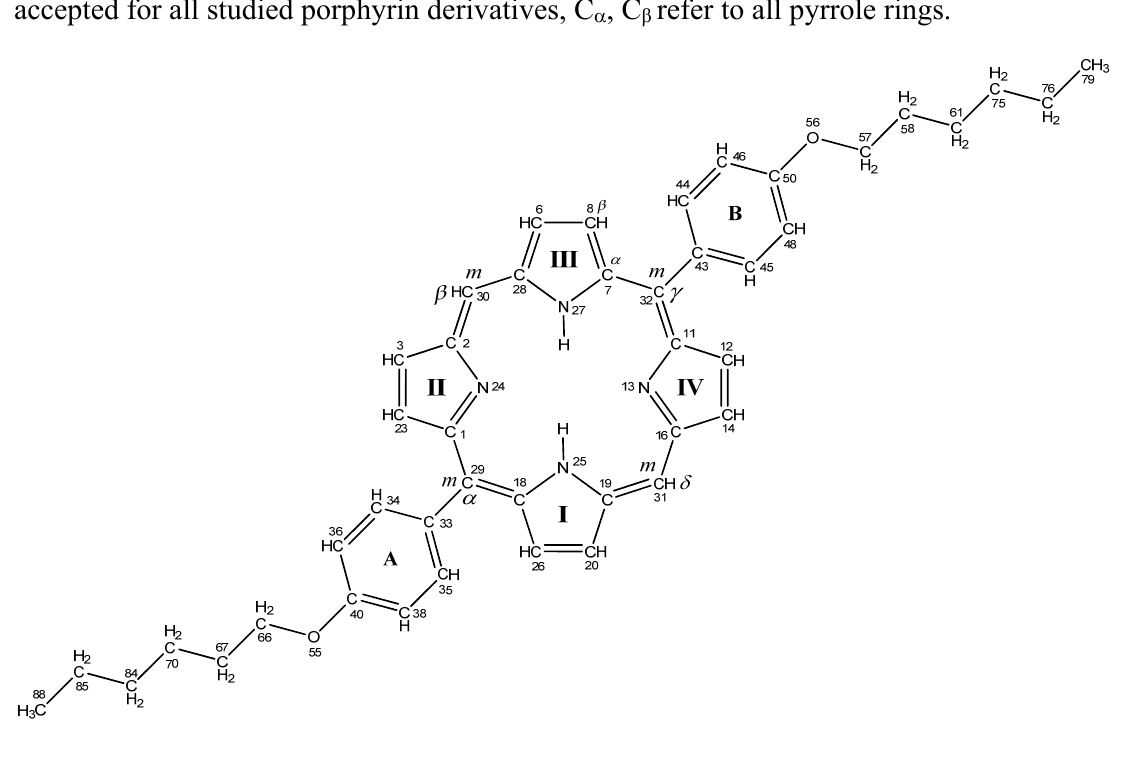
, m , m , m – are numbers for meso- carbon ( m ) β γ δ α